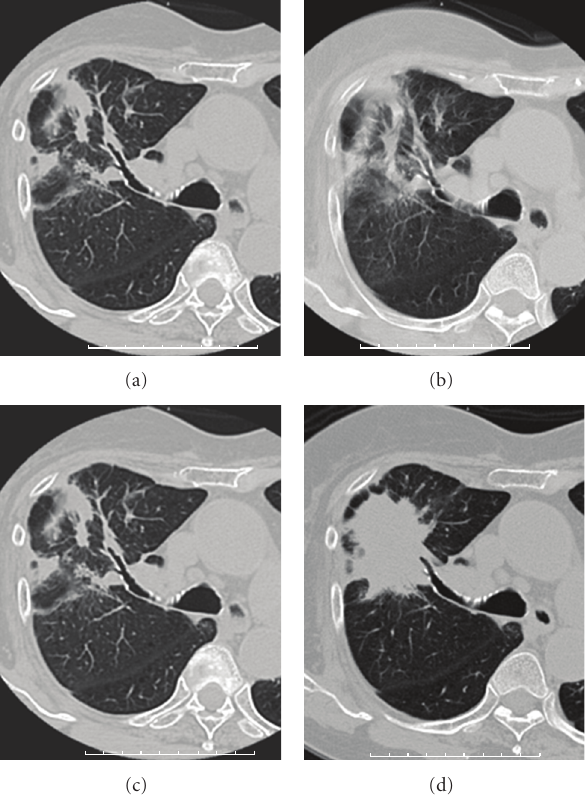
Figure 3: Serial CT images after SBRT. (a), (b), (c) CT images at 2, 6, and 9 months after SBRT show irregularly shaped patchy consolidation in the irradiated area. (d) CT images at 12 months after SBRT showing the appearance of mass-like consolidation in the irradiated area.